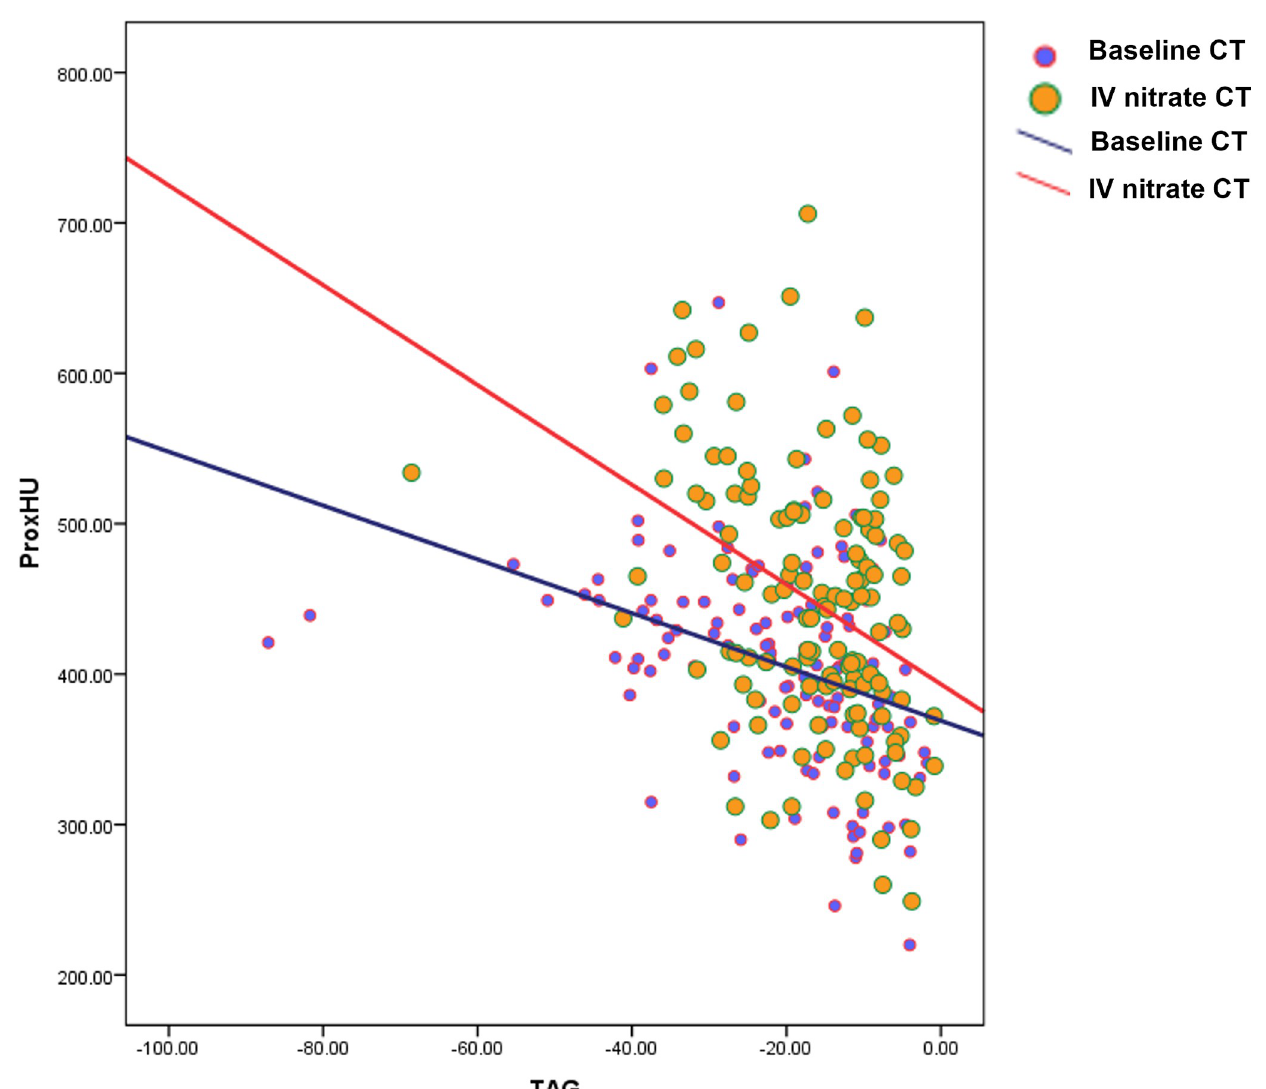
Fig 5. Correlation between the TAG and ProxHU values of coronary arteries. ProxHU values showed a weak negative correlation with TAG values (Baseline CT, r = -0.360; P < 0.001; IV nitrate CT, r = -0.385; P < 0.001). This trend was observed regardless of the CT acquisition method.